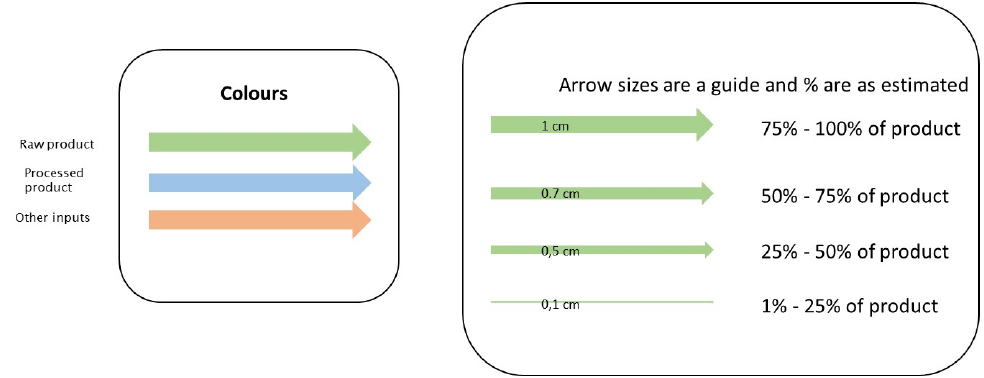
Figure A1. Example of a food system and its subsystem nodes.